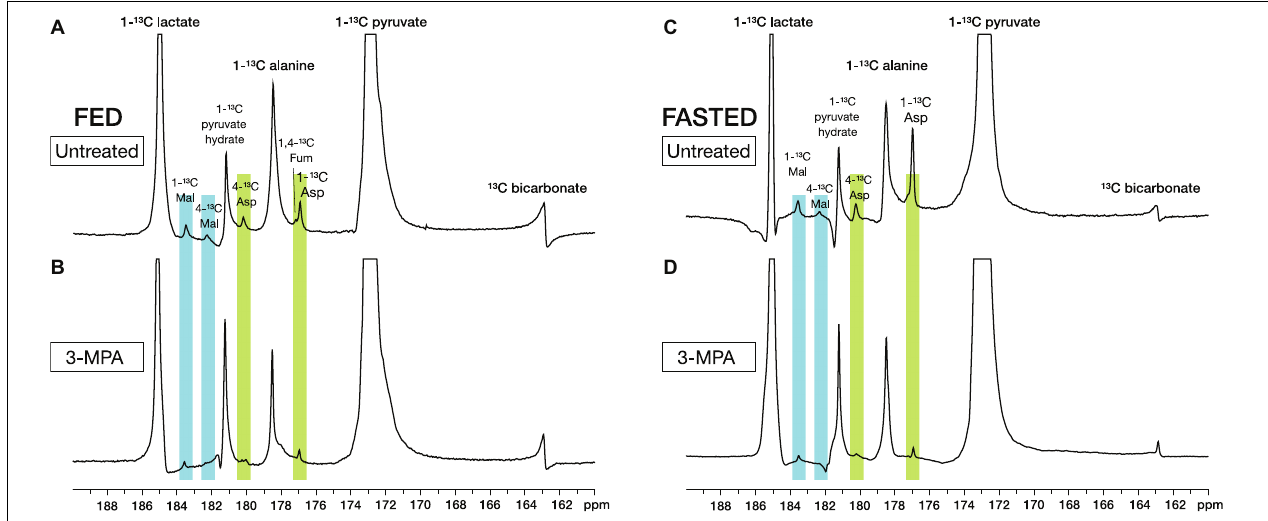
FIGURE 2 | Representative high-resolution spectra of in vivo renal metabolism of infused hyperpolarized [1- 13 C]pyruvate in fed (A,B) and fasted (C,D) rats. The metabolites [1- 13 C]lactate, [1- 13 C]alanine, [ 13 C]bicarbonate, [1- 13 C]- and [4- 13 C]aspartate, [1- 13 C]- and [4- 13 C]malate, and [1/4- 13 C]fumarate can be resolved. Treatment with the PEPCK inhibitor 3-MPA results in visibly decreased conversion to aspartate and malate. The spectra shown are sums of individual metabolite-containing spectra following a single infusion and are scaled to 9 × the height of the pyruvate